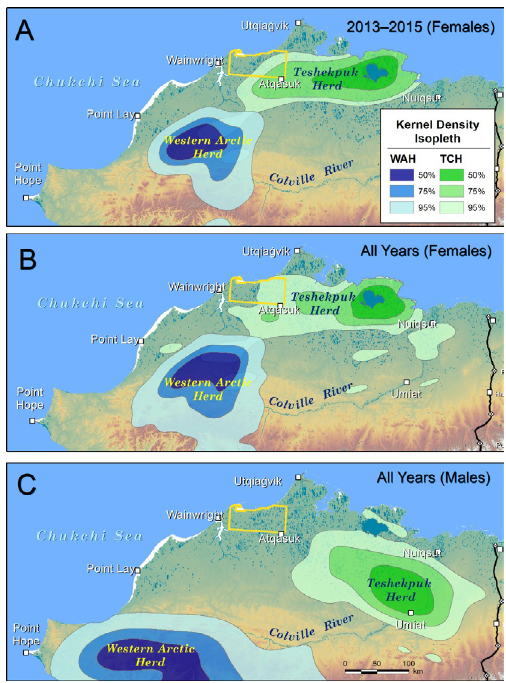
Figure 3. The predicted herd ranges for the Western Arctic (WAH) and Teshekpuk Herd (TCH) during early June based on kernel density estimation of telem- etry data from females during the years 2013–2015 only (A), females during all years (B), and males dur- ing all years (C). The aerial survey study area is desig- nated with a yellow